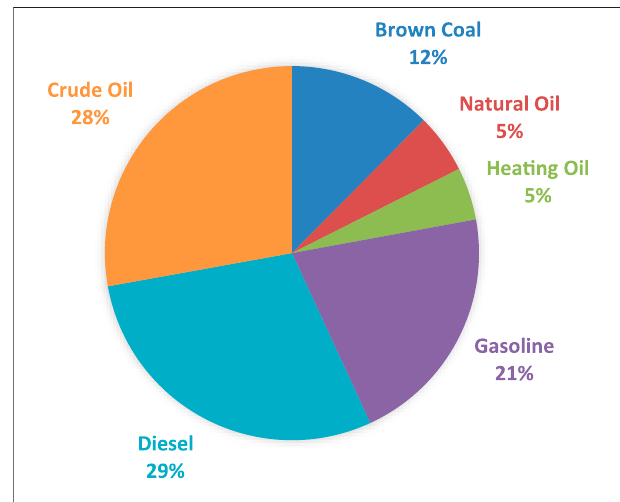
FIGURE 1 | Energy products price volatility (in